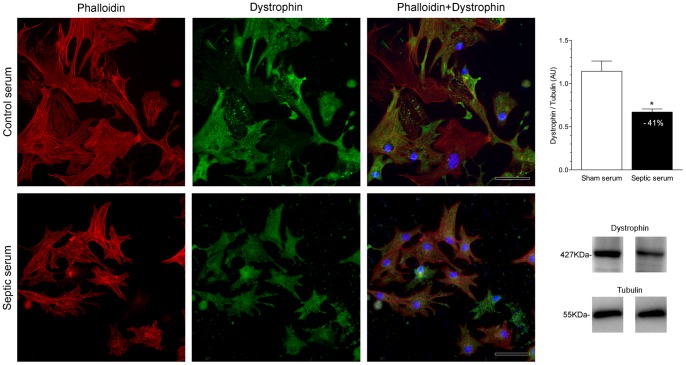
Decreased expression and amount of dystrophin in cultured cardiomyocytes stimulated with septic serum.The fluorescent signal for dystrophin (green fluorescence) presented decreased expression (bottom panel) with bleb formation in cardiomyocytes stimulated with septic serum in comparison with the fluorescence expression in cardiomyocytes expose to serum from sham-operated mice (upper panel). F-actin was stained with phalloidin conjugated Alexa Fluor 594 dye (red fluorescence) and DNA with DAPI (blue fluorescence). Alexa Fluor 594 staining showed disruption and rearrangement of F-actin filaments. Western blotting demonstrated that dystrophin amount was markedly decreased, around 41%, in cardiomyocytes stimulated with serum from septic mice compared to amounts observed in cardiomyocytes stimulated with serum from sham-operated mice (*, P<0.01). α-Tubulin was used as a protein loading control. Data are expressed as mean ± S.D. Scale bars indicate 50 μm.